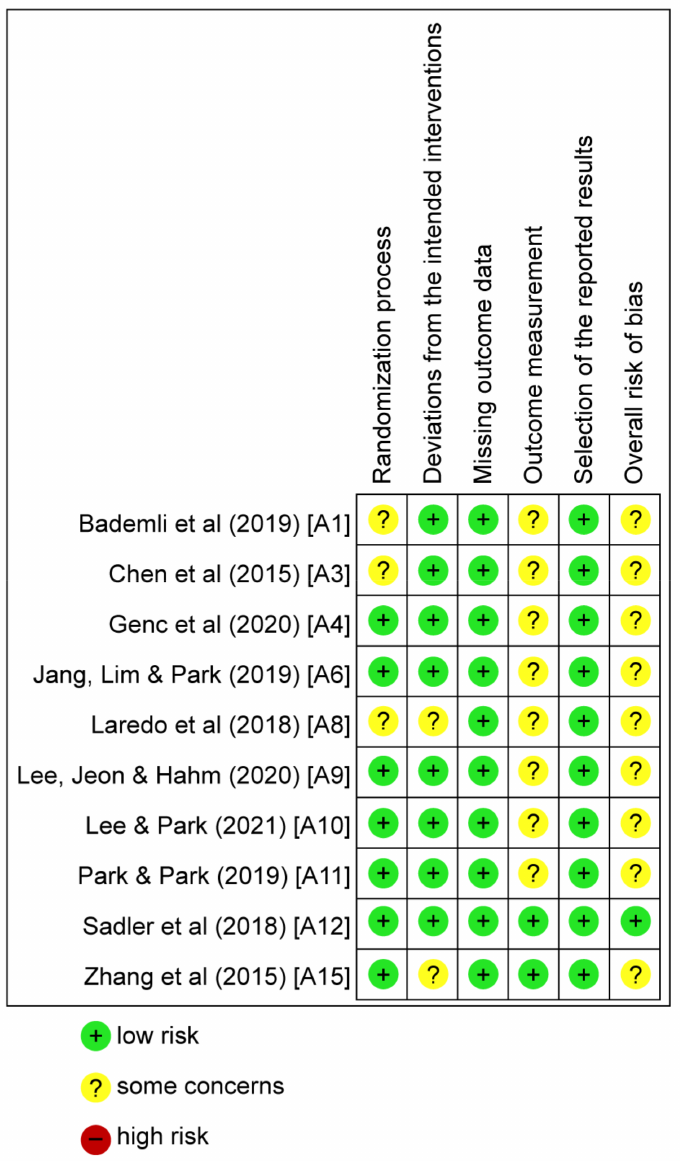
Figure 2. Risk of bias graph. Green represents low risk, yellow represents some concerns, and red represents high risk